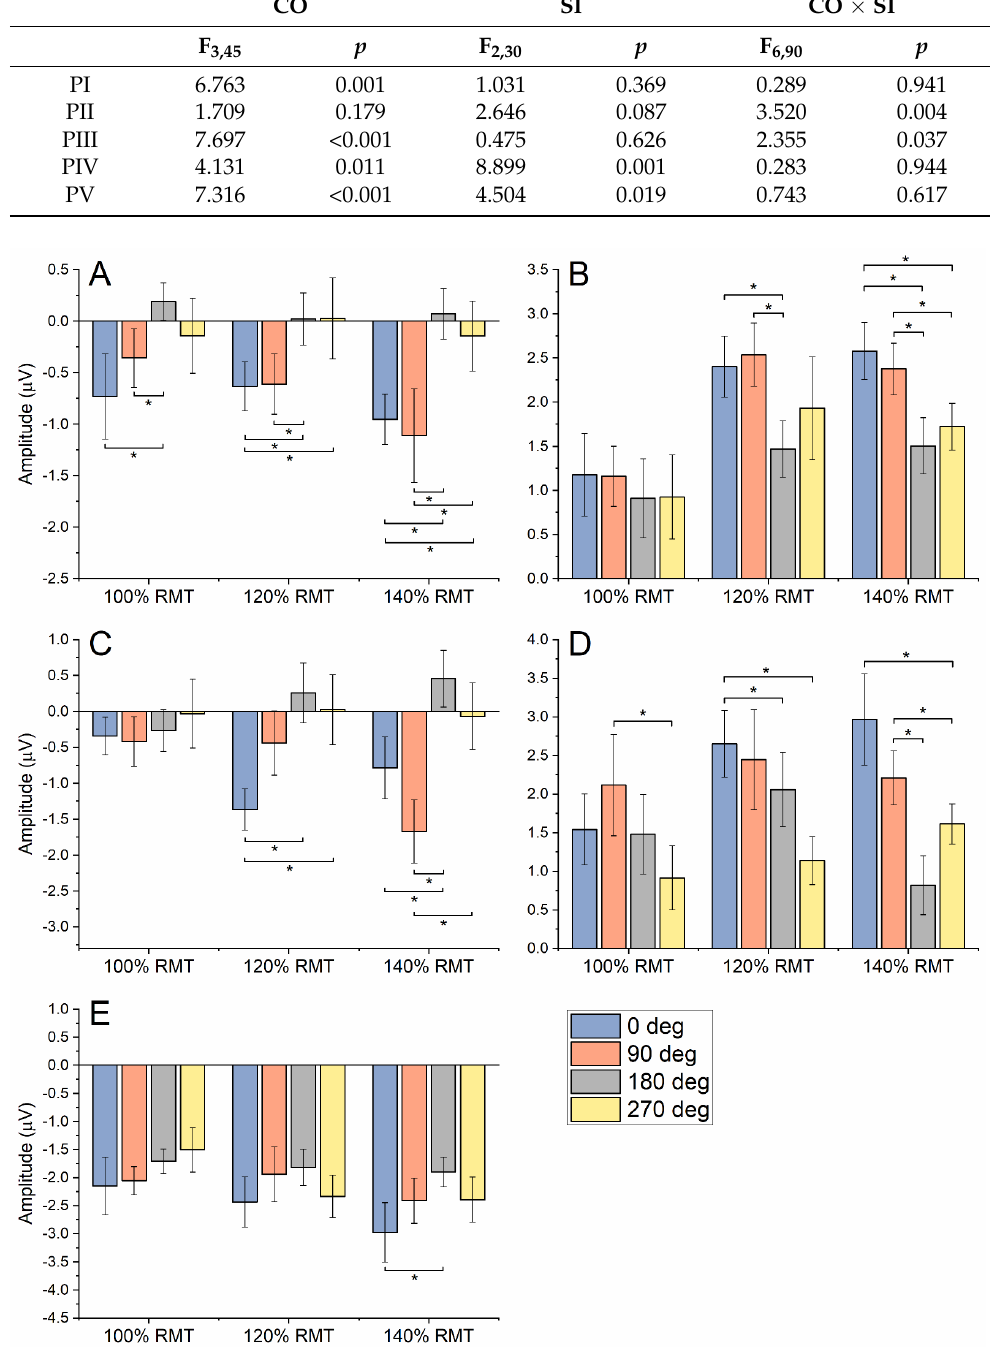
Figure 5. Summary of results on TEP peaks: panel ( A ), PI; panel ( B ), PII; panel ( C ) , PIII; panel ( D ), PIV; panel ( E ), PV. Error bars indicate standard error of the mean. Asterisks indicate statistical significance ( p < 0.05).